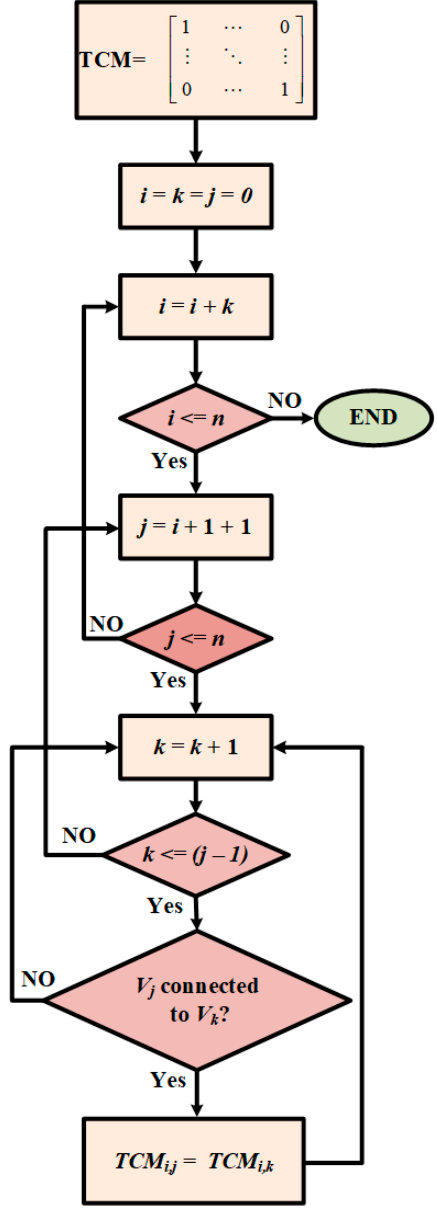
Figure 5. Flowchart for [ TCM ] calculation.